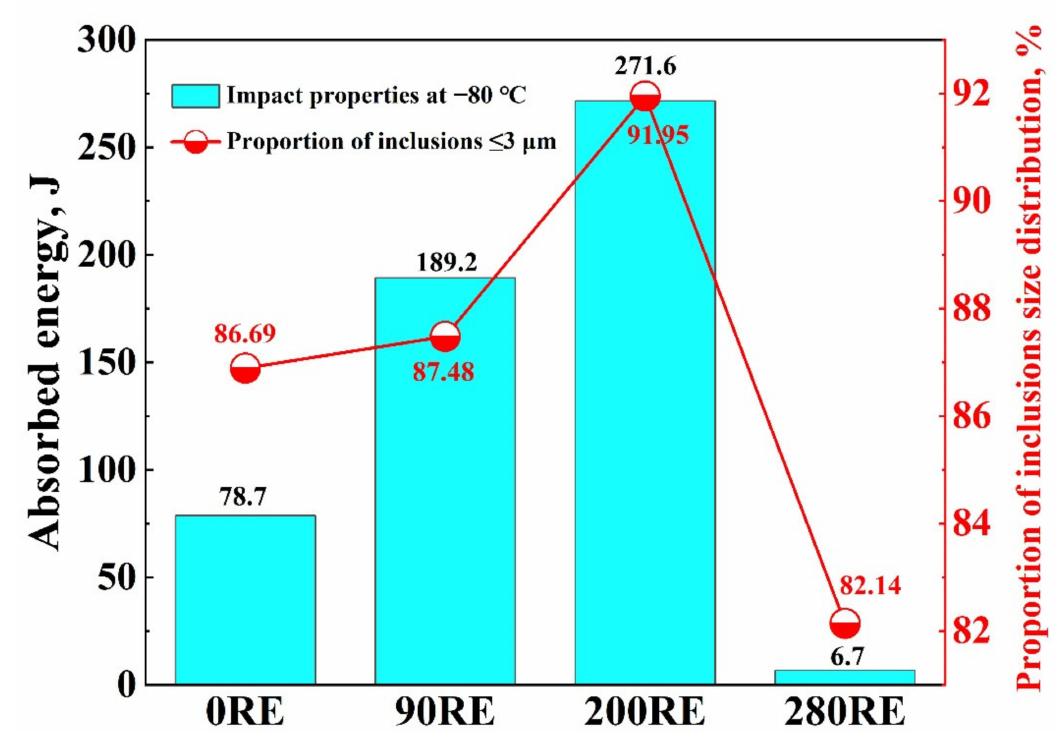
Figure 12. Relationship between impact properties and proportion of